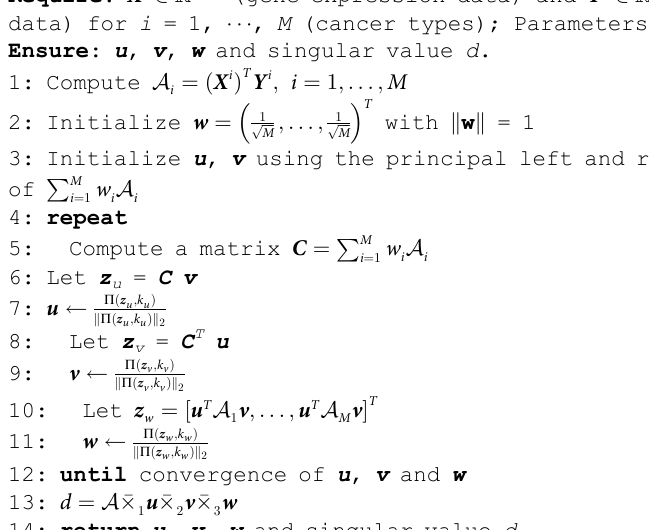
Algorithm 1 TSCCA algorithm solves Eq